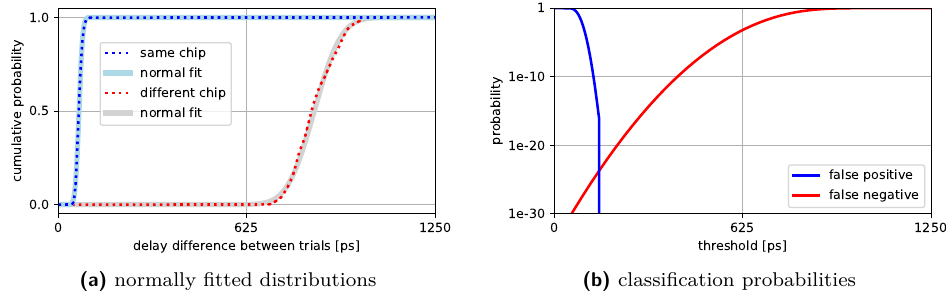
Figure 14: Fitted distribution lines for within-class and between-class distributions from Fig. 9b and type I and type II error probabilities across classification